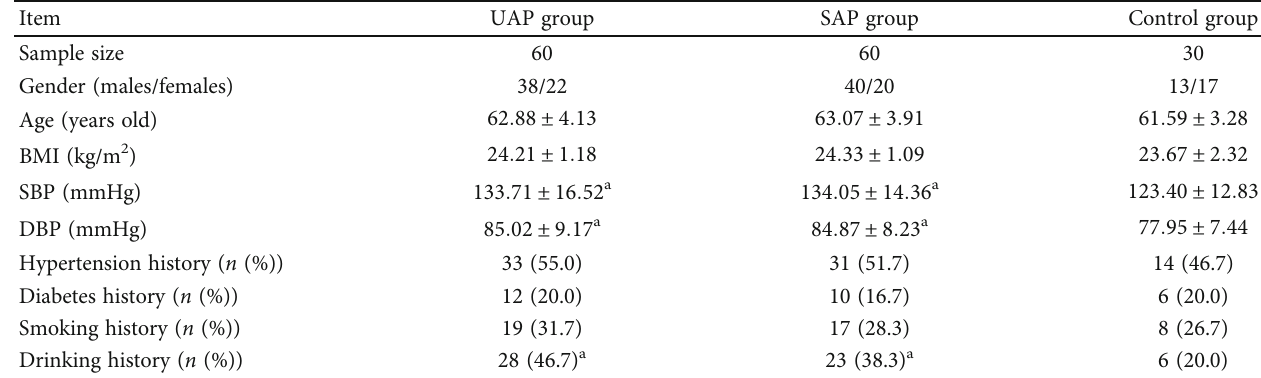
Table 2: Basic data of patients in three